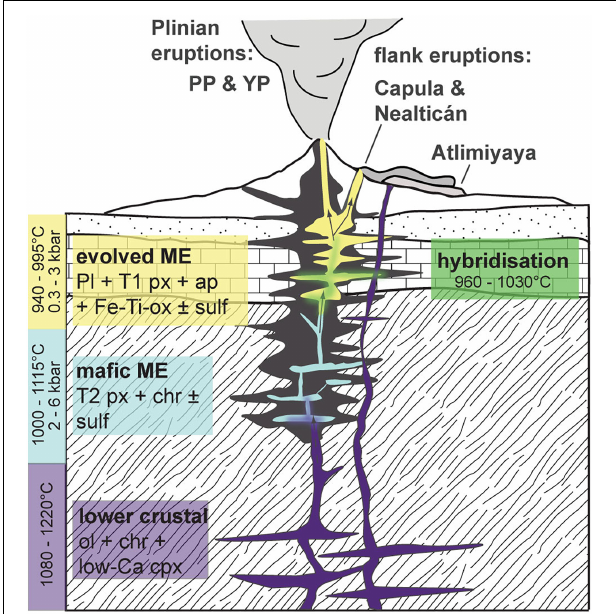
FIGURE 13 | Schematic model of the plumbing system of the PVC as inferred from products of effusive and explosive eruptions in the last ∼ 14.1 ka. ME = magmatic environment. See text for